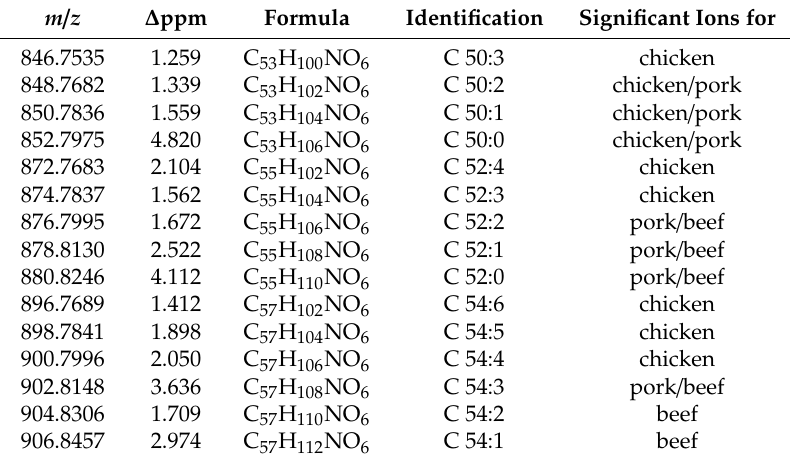
Table 3. Characteristic ions for pork, beef and